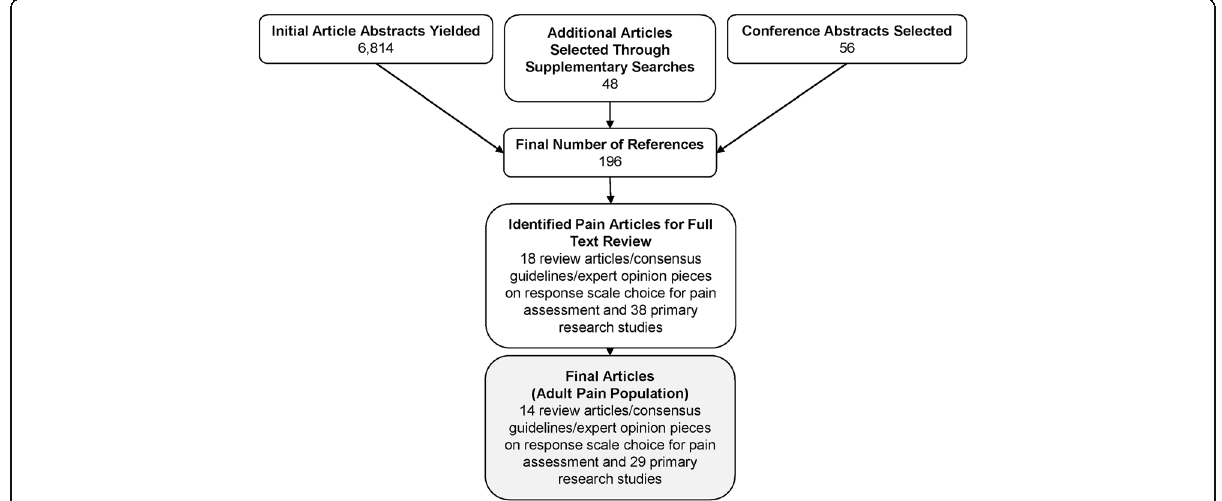
Fig. 1 Screening and review process for pain-related references*. *The top row covers all initial seven search objectives and proceeds